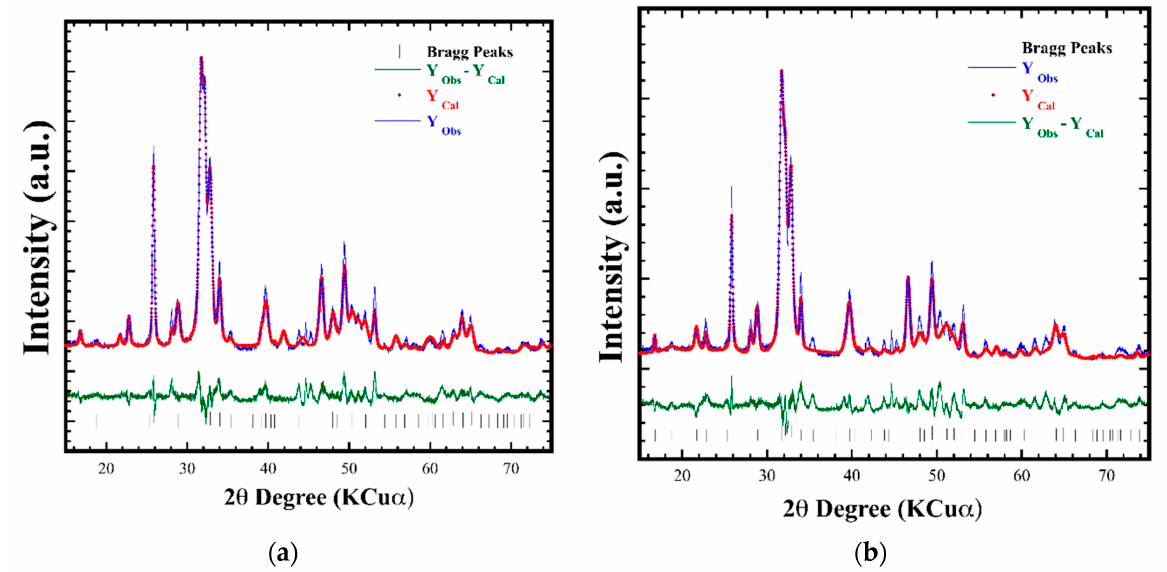
Figure 2. Rietveld refinement plot of Si-HAp powders prepared with different content of Si 4+ : ( a ) 6 mol% and ( b ) 20 mol% using (TMAS) [(CH3) 4 N(OH).2SiO 2 ] with a molar ratio of 1:3.0 (1.8 M), precursor, under microwave-assisted hydrothermal conditions at 150 ◦ C for 1h, pH =